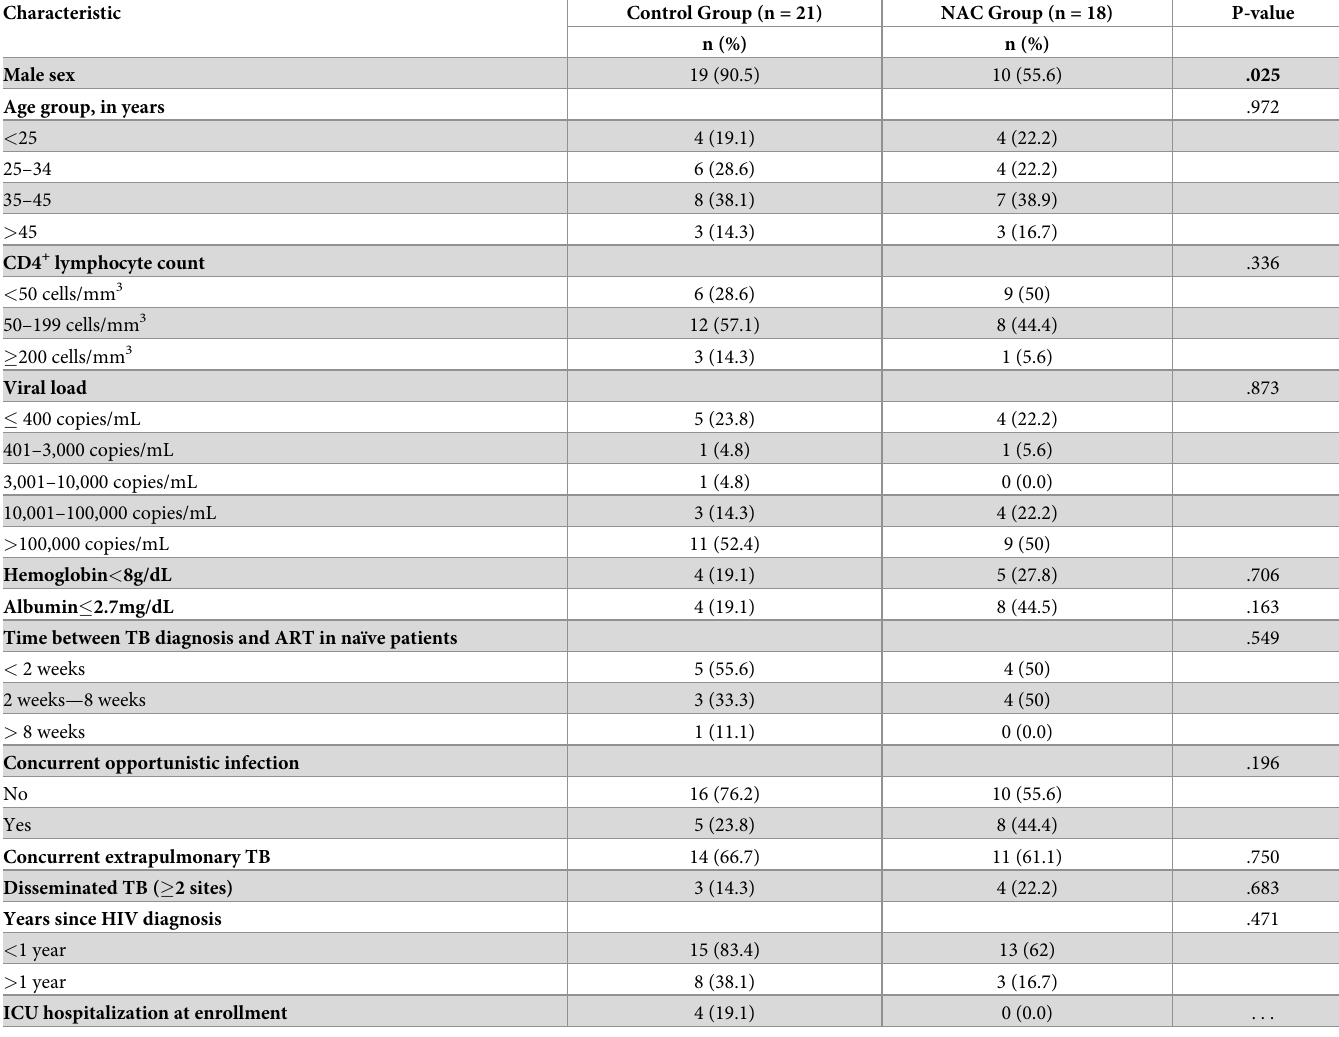
Table 1. Baseline characteristics of patients enrolled in both